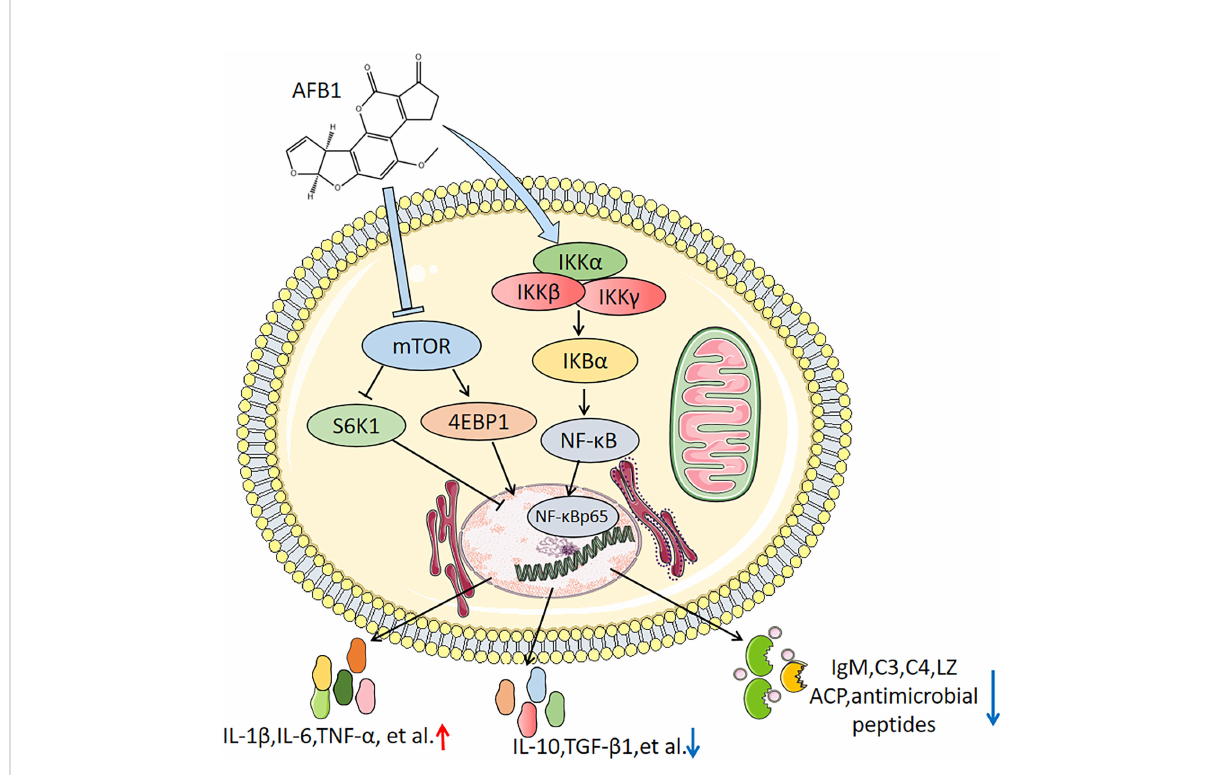
FIGURE 7 The mechanism of AFB1 on immune function of immune cells in the skin, spleen and head kidney of grass